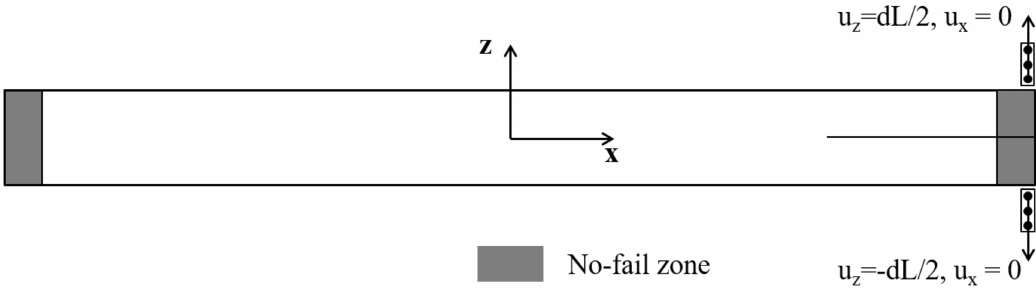
Figure 5. Boundary conditions for PD DCB